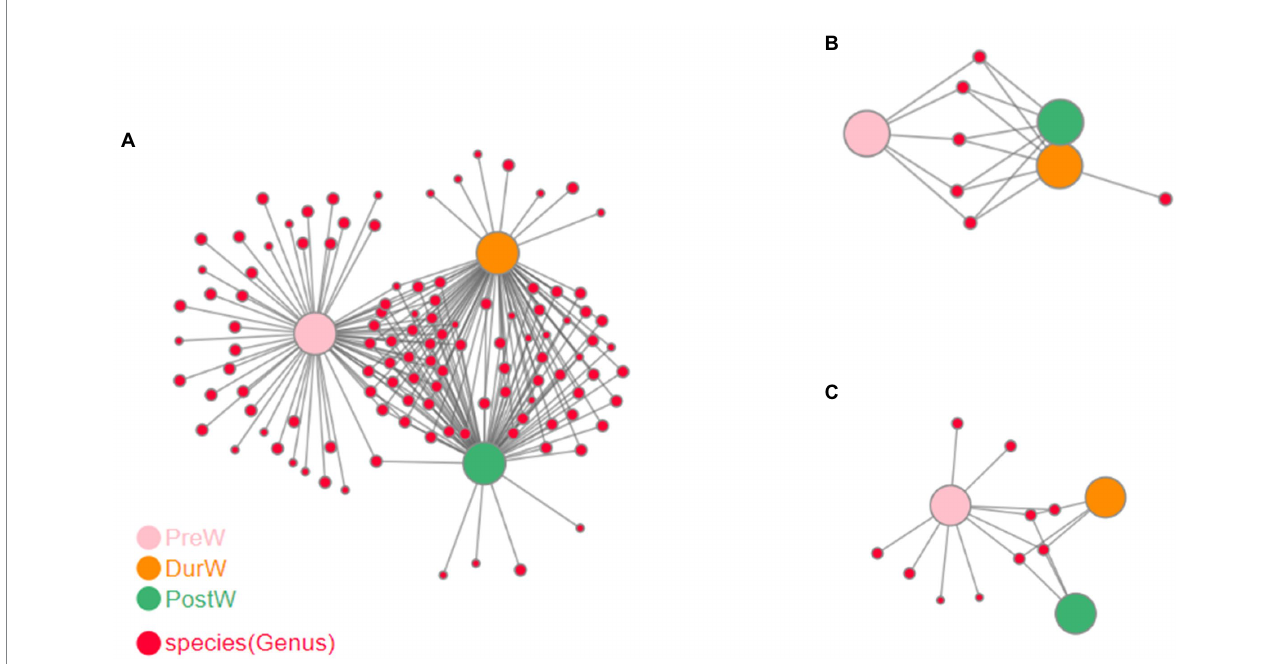
FIGURE 7 Co-occurrence network analysis on microbiota among different groups. ( A) The network analysis of bacteria. ( B) The network analysis of anaerobic fungi. ( C) The network analysis of archaea; PreW, pre-weaning donkeys; DurW, during weaning donkeys; PostW, post-weaning